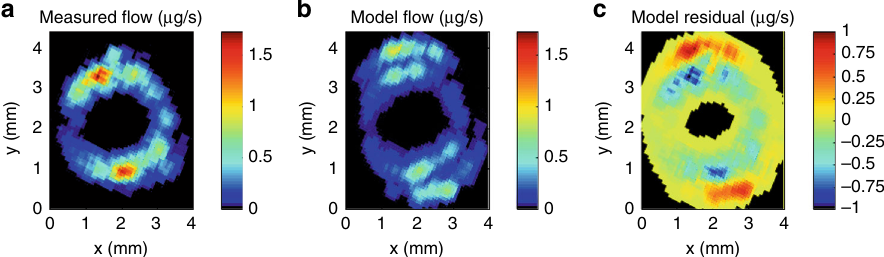
Fig. 3 Baseline scenario. a Observed fl ow rates ( µ g s − 1 , colour scale) averaged in 5-by-5 pixel window. b Model predicted fl ow rates ( µ g s − 1 , colour scale) with single pressure value set at top of domain, downsampled to 78 µ m resolution and averaged over 5-by-5 pixel window. c Residuals between model and observed ( µ g s − 1 , colour